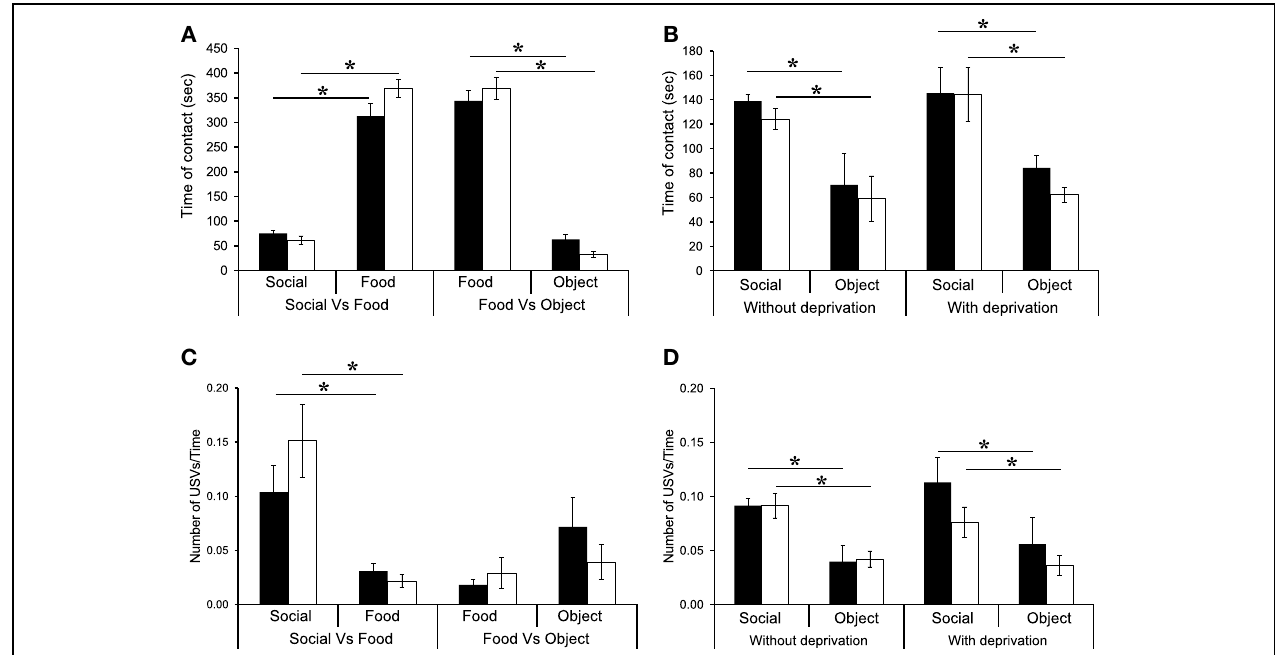
room. (D) Reduction of Pf mean observed between the first session (without deprivation) and the second session (food deprivation) of the 3Ch task. Datas are presented for WT and β 2 − / − mice as mean ± SE. ∗ p < 0 . 005; for Mann-Whitney paired